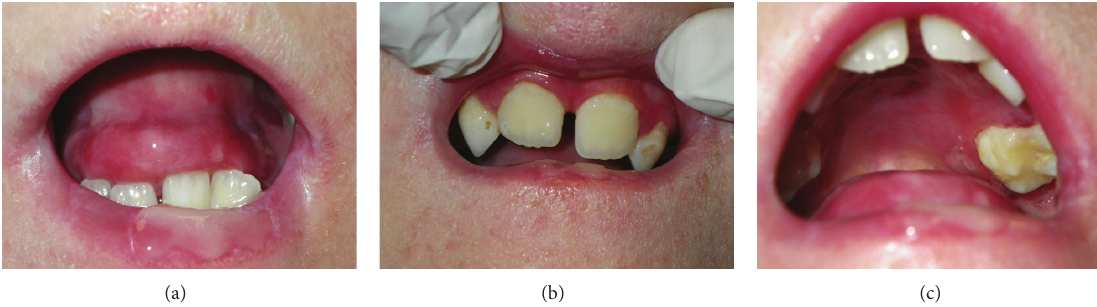
Figure 1: Intraoral aspects in a patient with DEB (microstomia, caries, absence of lingual papillae, and blood- and fluid-filled bullae).